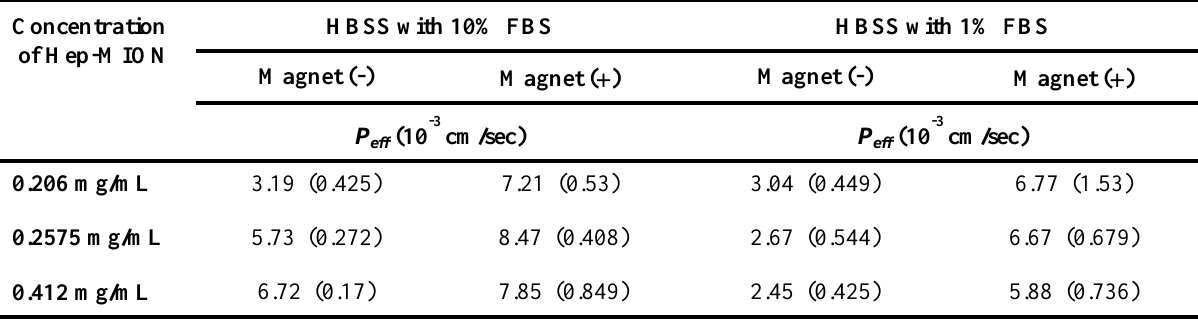
Table 1. Comparing the transport behavior of Hep-MION in HBSS with 10% or 1% FBS, with or without the applied magnetic field. Permeability coefficients ( P ) were assessed eff with three different concentrations of nanoparticles (0.206, 0.2575 or 0.412 mg/mL) in triplicates. Average values of P are displayed with standard deviations in the eff